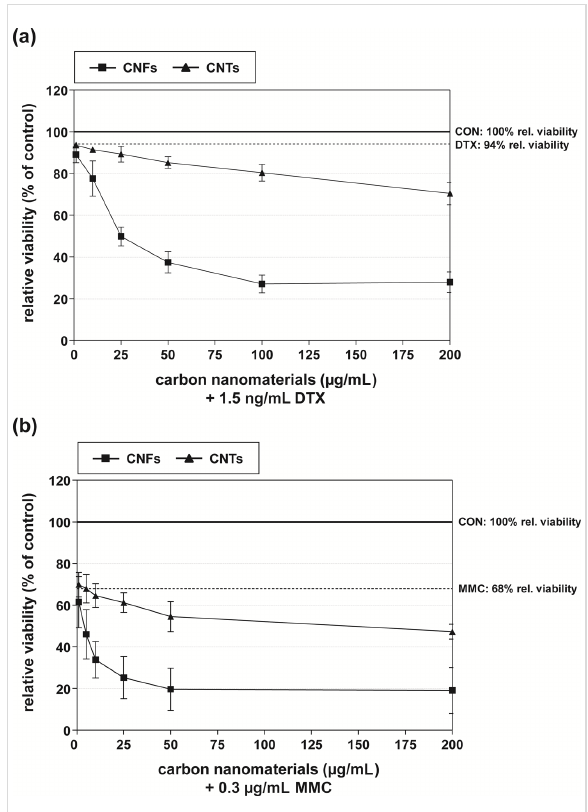
Figure 1: Relative cellular viability of DU-145 cells treated with (a) 1.5 ng/mL DTX or (b) 0.3 µg/mL MMC in combination with increas- ing concentrations of CNFs and CNTs (1–200 µg/mL), respectively. Results are depicted as averaged relative cellular viability (%) ± rela- tive mean deviation. Untreated cells (CON) served as control (100%). The cellular viability rate following exposure to the respective chemotherapeutic alone is also